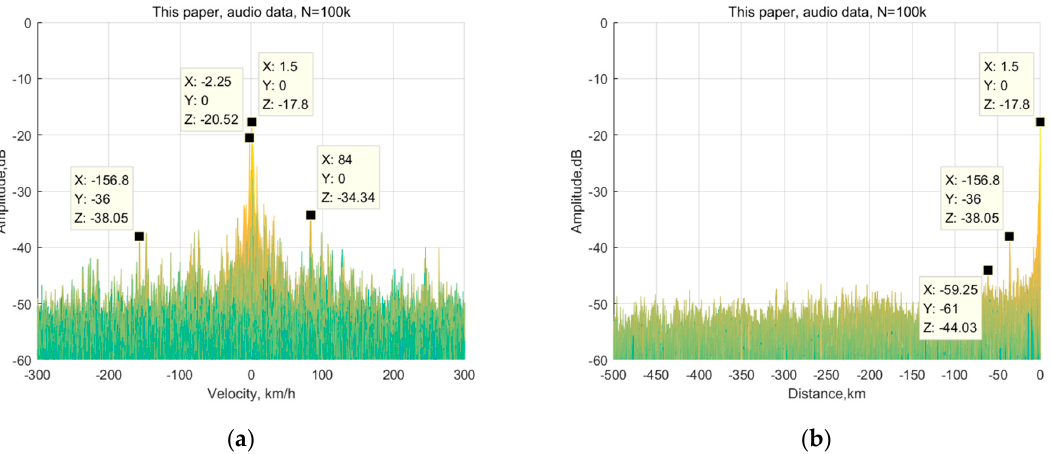
Figure 18. Integration results obtained with the proposed method for the audio signal: N = 10 5 ; ( a ) Doppler dimension; ( b ) Range dimension.